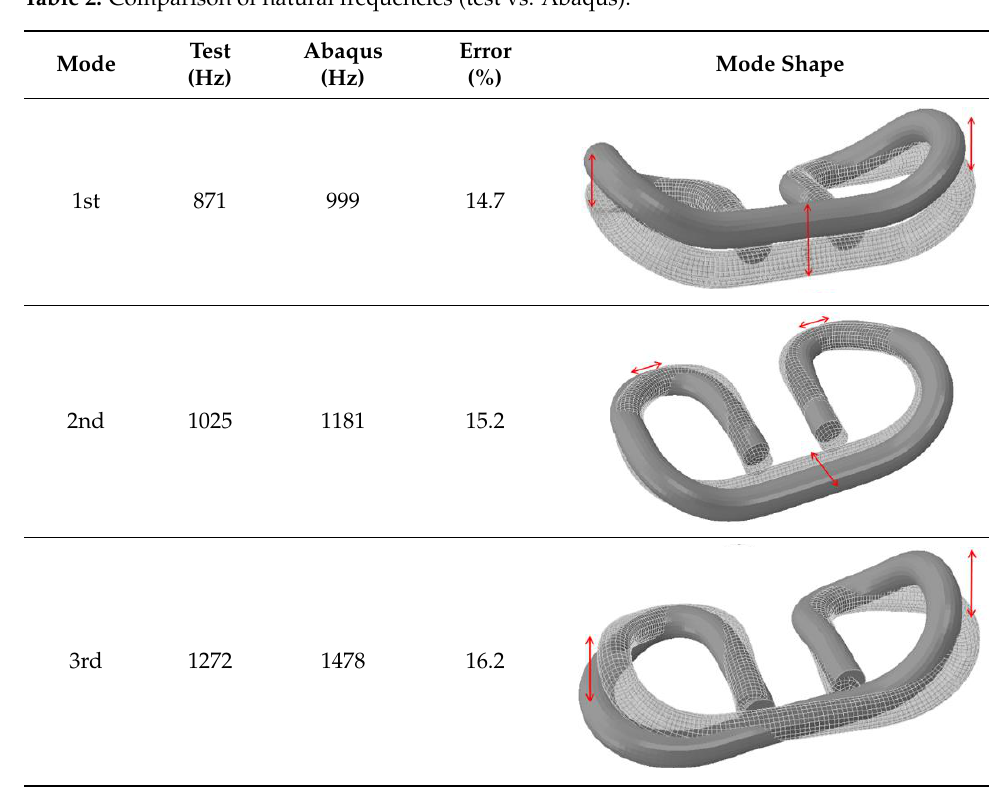
Table 2. Comparison of natural frequencies (test vs.